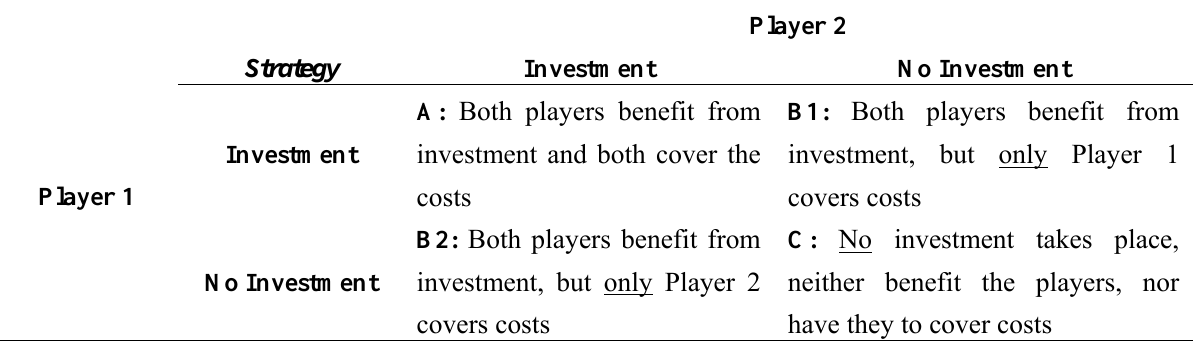
Table 1. Schematic formulation of a prisoners’ dilemma on infrastructure